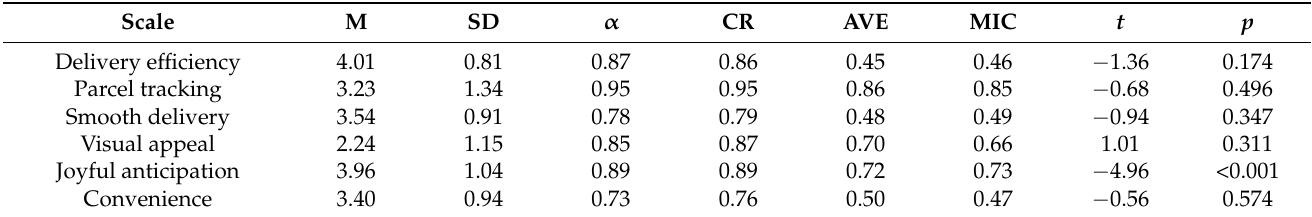
Table 3. Psychometric properties and gender differences of the CDX-LMD scales ( N =